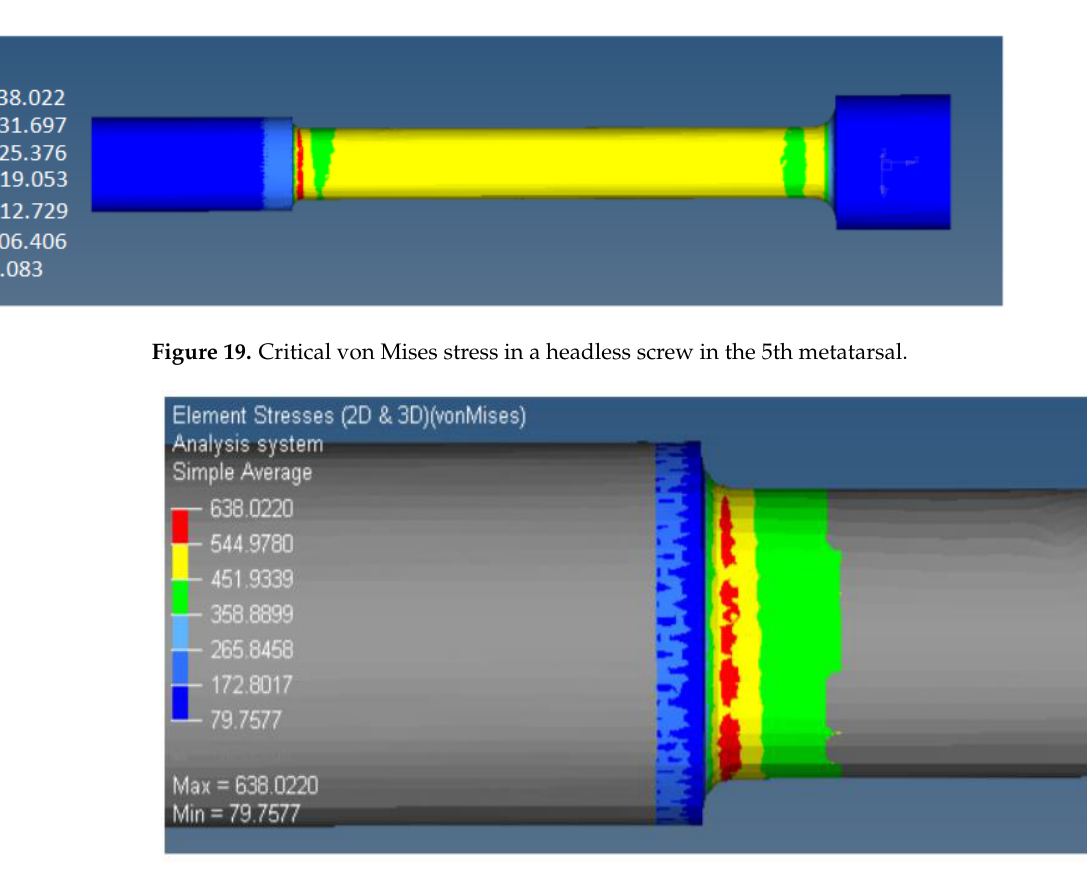
Figure 20. Detail of critical stress in a headless screw in the 5th metatarsal.